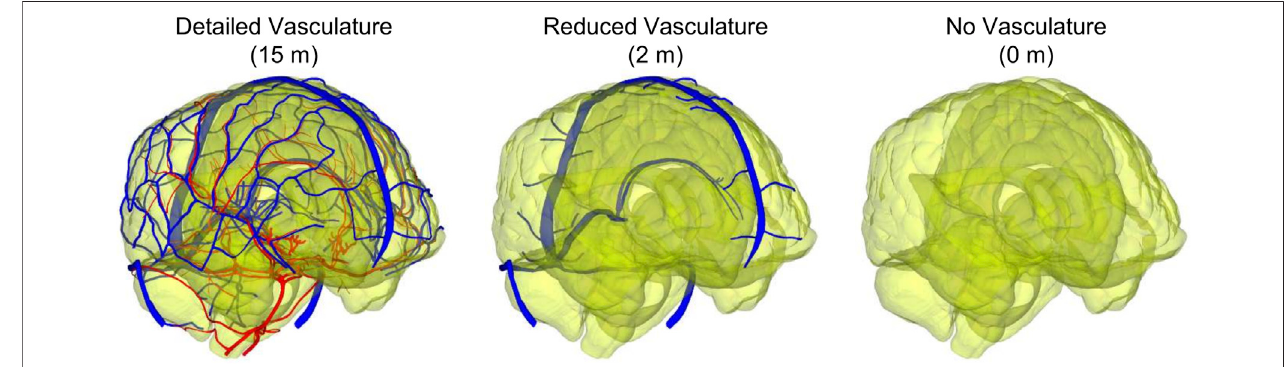
FIGURE 1 | Comparison between the detailed-vasculature (15 m), reduced-vasculature (2 m), and no-vasculature (0 m) models. (Note: the arteries and veins are displayed in red and blue, respectively, whereas the brain is displayed with a transparent color.).